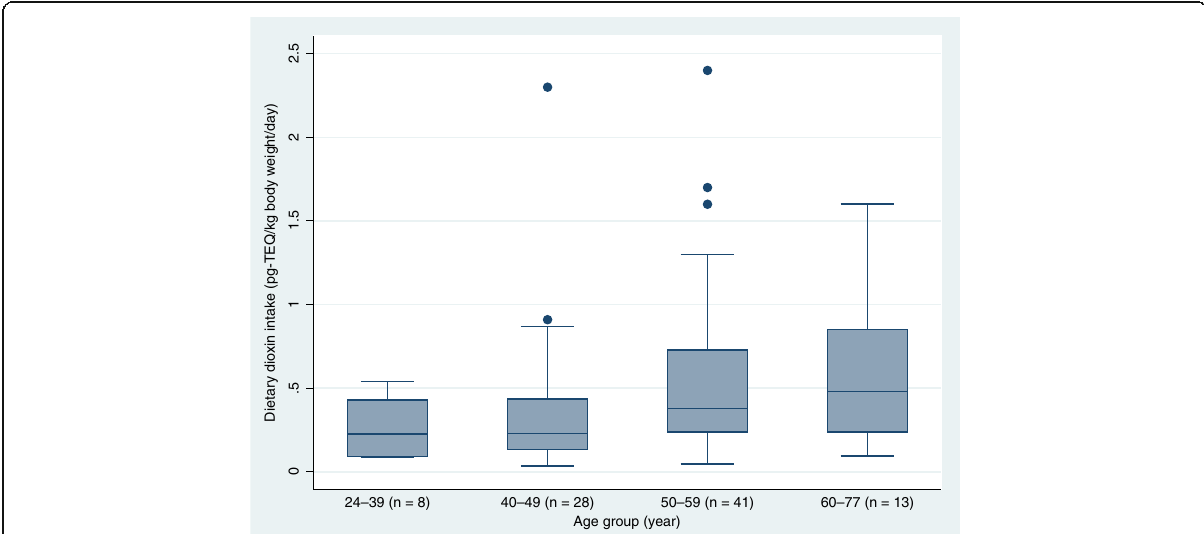
Fig. 4 (Showing whiskers): Estimated dioxin dietary intake by age. Box plot of total TEQ in food by age group of the ‘ survey on the exposure to dioxins and other chemical compounds in humans, ’ 2011 to 2016 (N = 90). The median (range) of dioxin dietary intake (in pg TEQ/kg body weight/day) by age group (year) was 24 – 39, 0.22 (0.08 – 0.54); 40 – 49, 0.23 (0.03 – 2.3); 50 – 59, 0.38 (0.04 – 2.4); and 60 – 77, 0.48 (0.09 – 1.6). Kruskal-Wallis test: χ 2 = 8.87; d.f. = 3; p = 0.031. TEQ, toxic